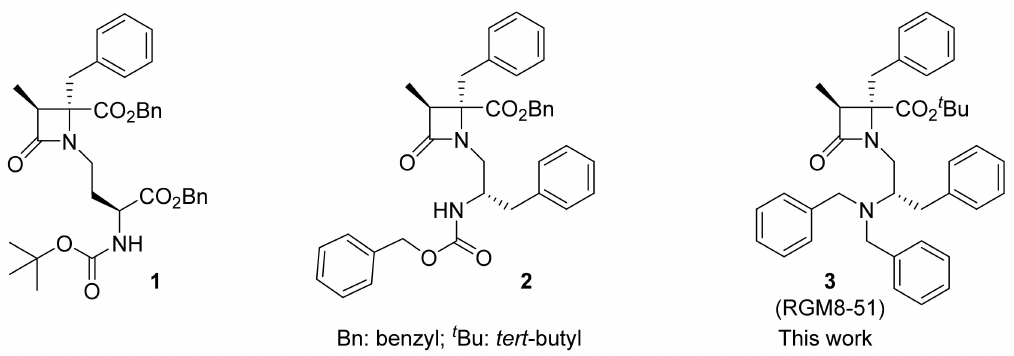
Figure 1. β –lactam TRPM8 antagonists: Compounds 1 and 2 came from previous works [30,31]; Compound 3 (RGM8-51), described in this